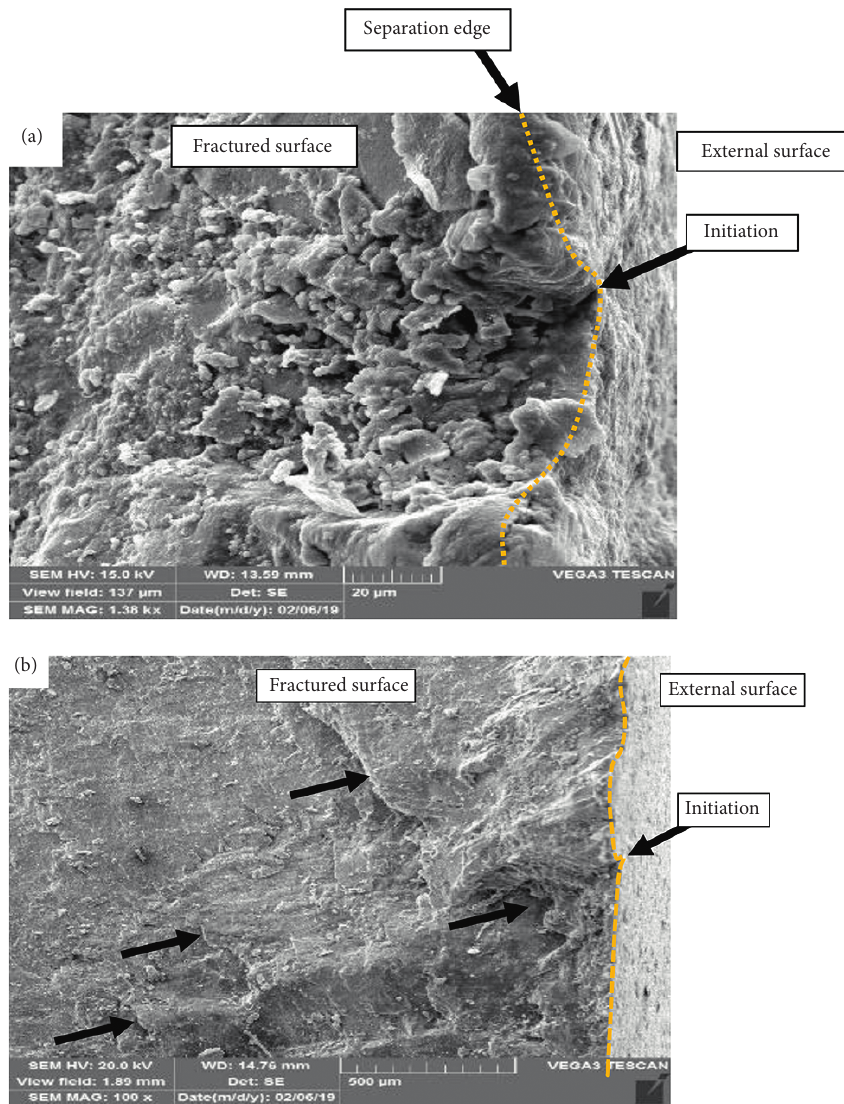
Figure 5: SEM fractured surface of S region in Figure 4 (a) sample 1 (b) sample